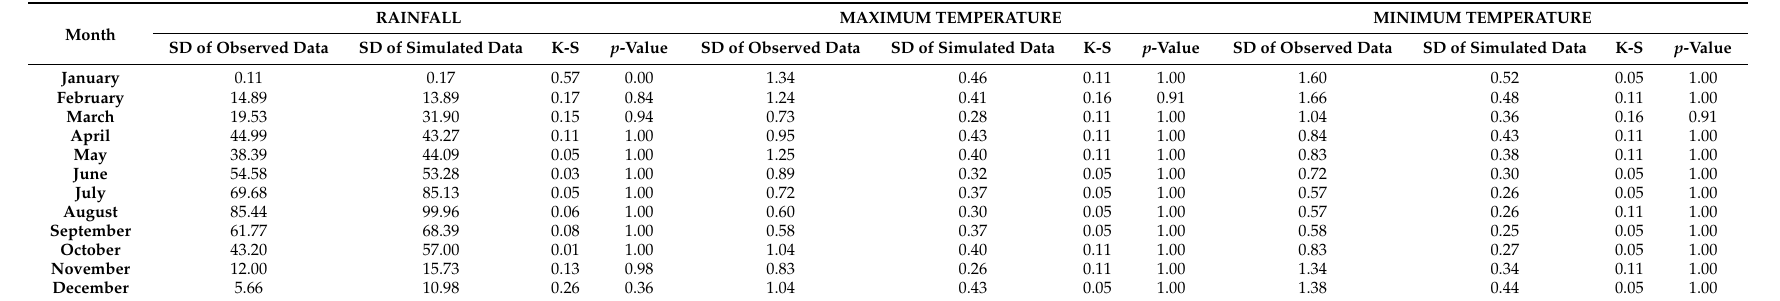
Table 5. Kolmogorov–Smirnov test statistics for rainfall, maximum and minimum temperatures in Dapaong.